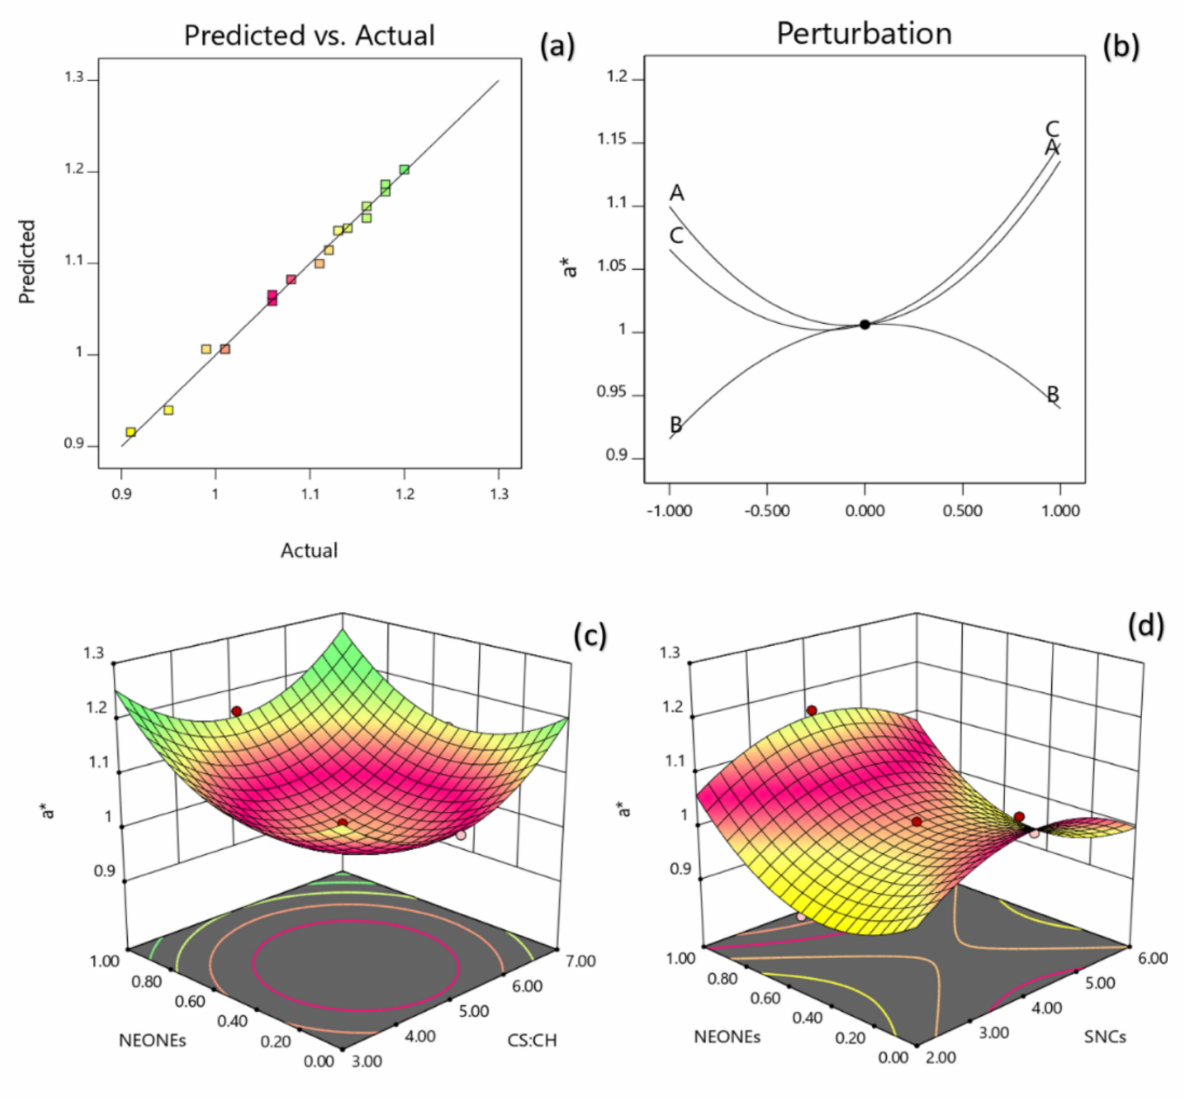
Figure 6. Counter and perturbation graphs ( a , b ), the interaction between CS:CH and SNCs concentration and also interaction between SNCs and NEONEs concentration on a* parameter of the produced film ( c , d